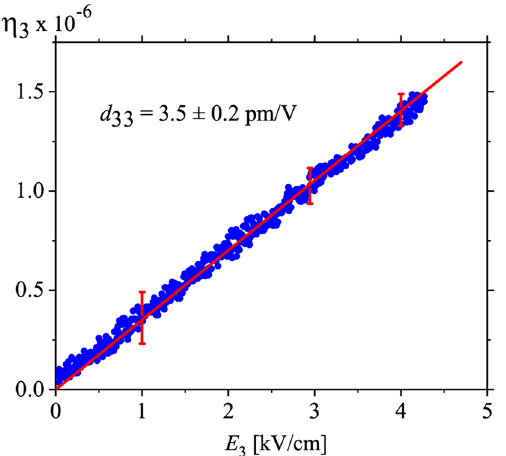
Figure 4. Strain η 3 as a function of a.c. electric field strength E 3 of frequency of 160 Hz at 300 K. To keep the crystal in thermodynamic equilibrium, slowly and continuous change of the E 3 field with the rate of 0.075 kV/ minute was applied. Since the electric field was applied in the direction [001], we have measured the d 33 piezoelectric coefficient. The red straight line represents a fit to the relationship describing the piezoelectric effect η 3 = d 33 E 3 .